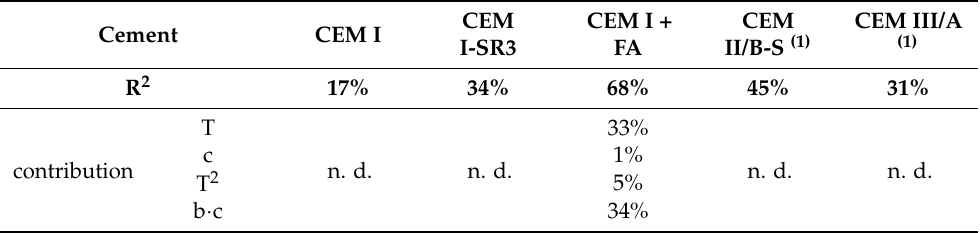
Table 6. Coefficient of variation R 2 and contribution of independent variables/interactions for regression models of the relative flexural strength (f f /f fm ) of concrete with w/c = 0.45 after 182 days storage in Na 2 SO 4 solution.